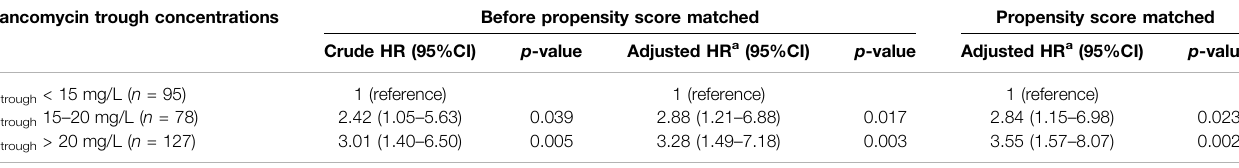
TABLE 4 | Subgroup of nephrotoxicity in patients infected with Enterococcus spp. classi fi ed by vancomycin trough concentrations. Vancomycin trough concentrations Before propensity score